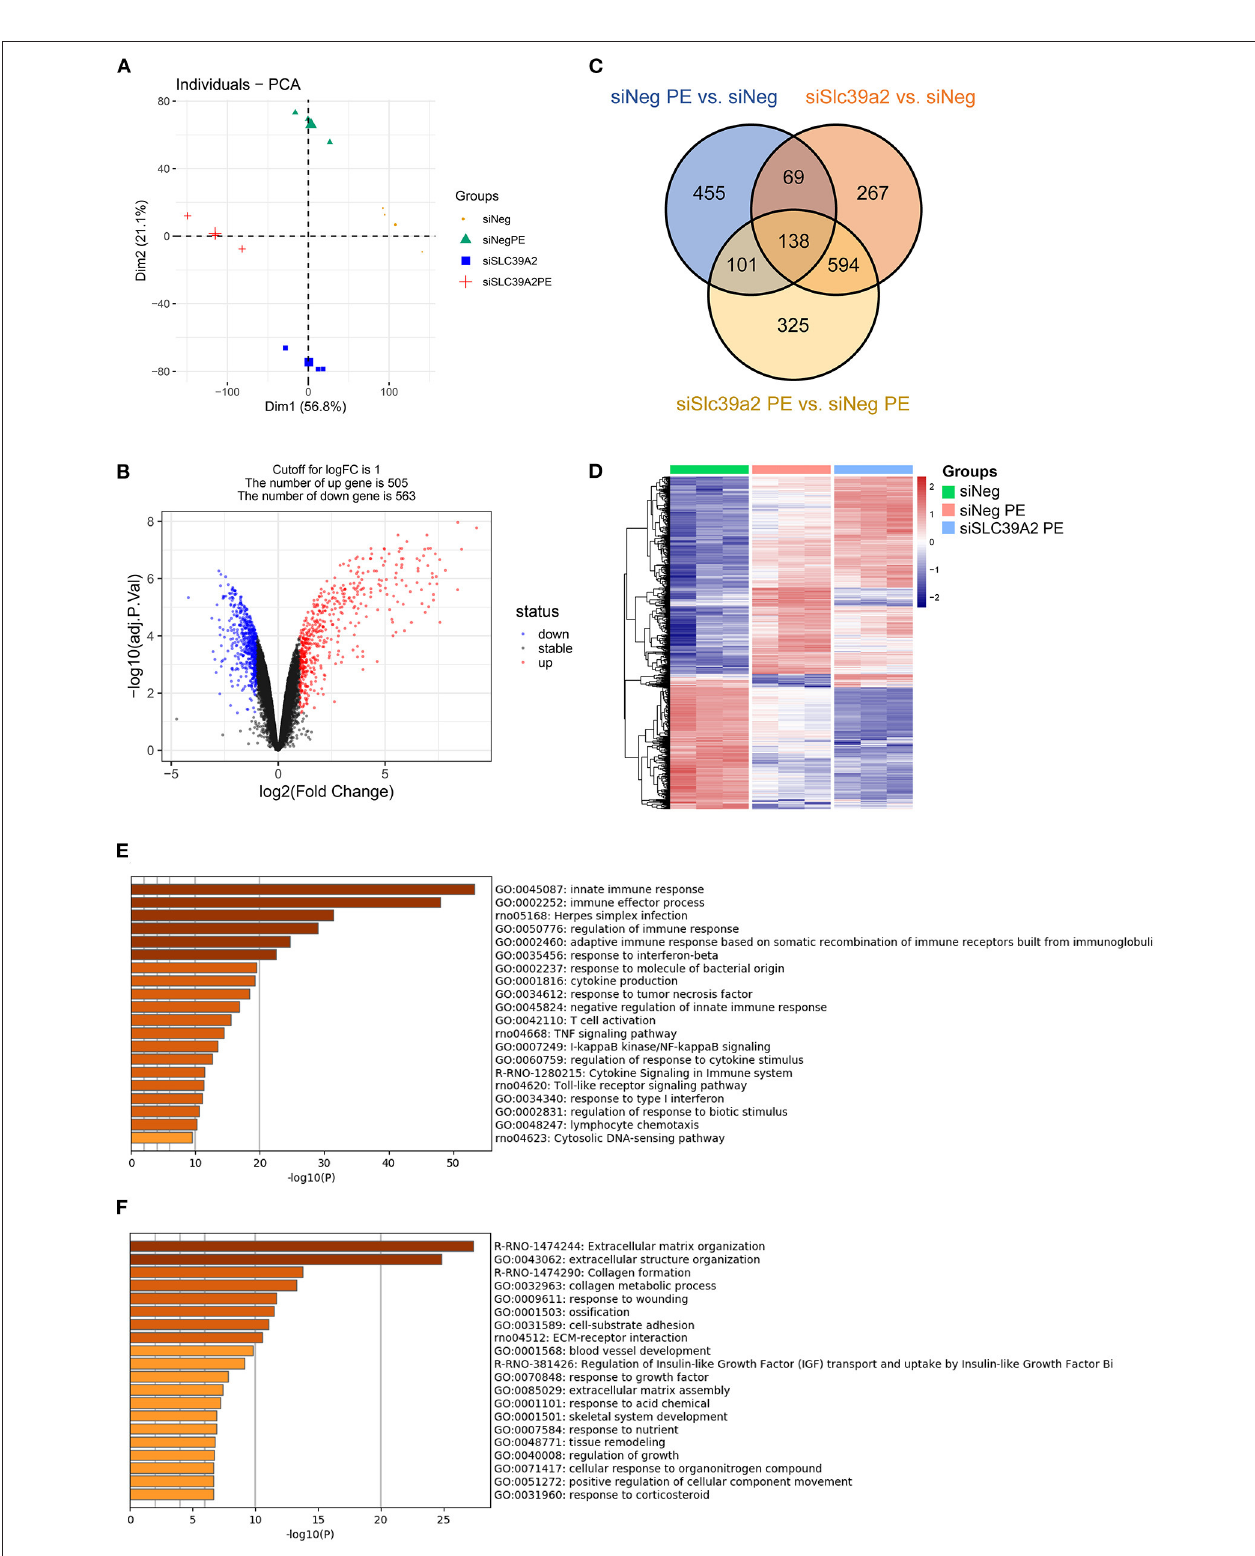
FIGURE 4 | Slc39a2 deficiency potentiates the transcriptome reprogramming induced by PE. (A) Principal component analysis (PCA) from the RNA-seq data showing the overall impact of Slc39a2 knockdown on the transriptome of NRVMs with or without PE treatment. (B) Volcano mapping showing the number of up- and down-regulated genes ( ≥ 2 folds) by Slc39a2 knockdown. (C) Venn map showing the relationship of differentially expressed genes among 3 comparisons (siNeg PE vs. siNeg; siSlc39a2 vs. siNeg; siSlc39a2 PE vs. siNeg PE). (D) Heatmap showing the impact of siSlc39a2 on PE-induced transcriptome reprogramming. (E,F) Gene Ontology (GO) analyses of up-regulated (E) and down-regulated (F) genes by siSlc39a2 measured by Metascape.